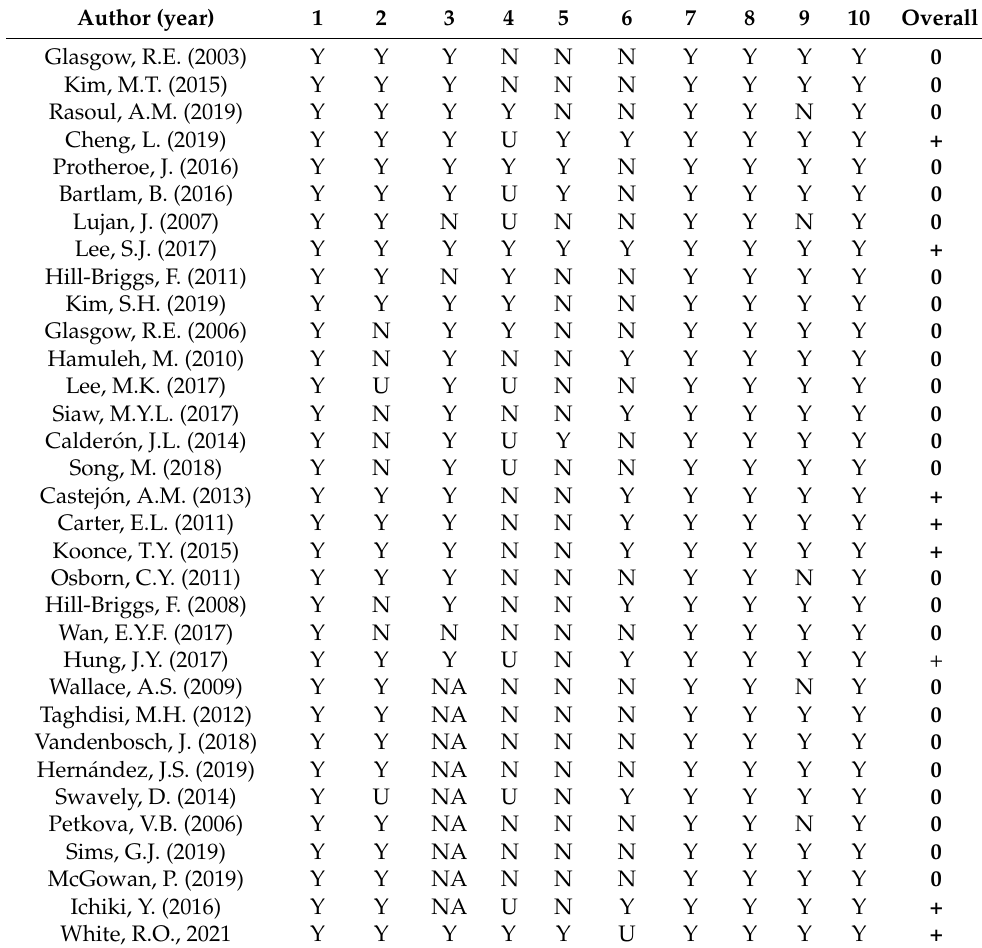
Table 2. Quality assessment attributes for each quantitative study included in the current systematic review, assessed by the Academy of Nutrition and Dietetics’ Quality Criteria